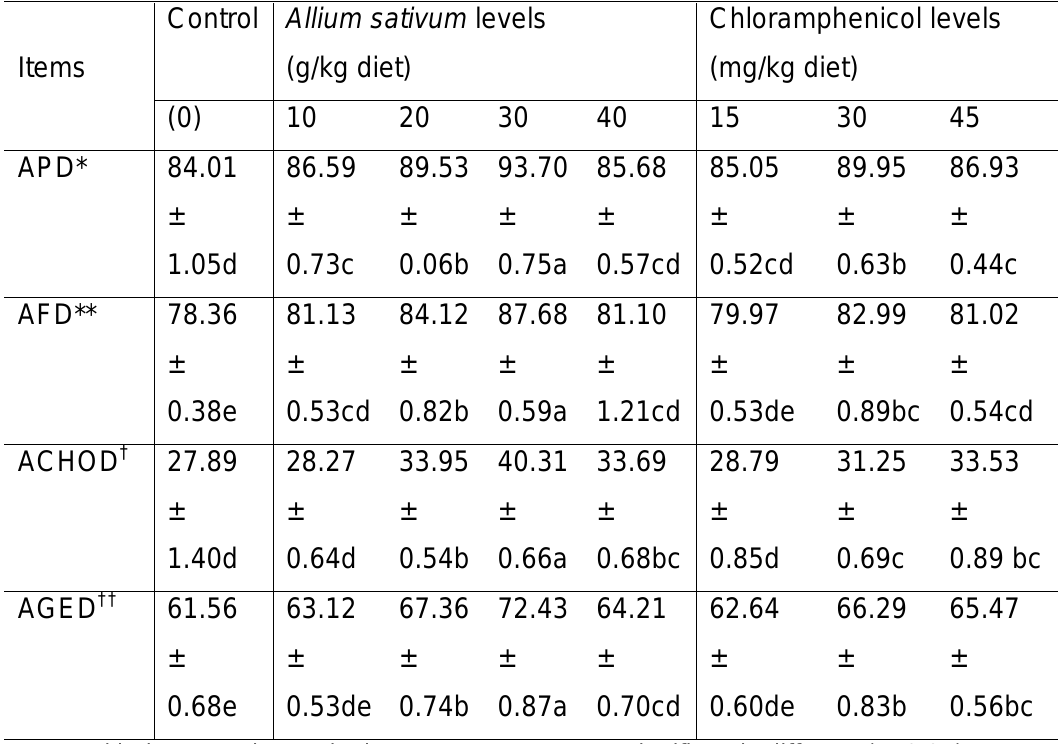
Table 3: Apparent nutrients digestibility (%) for garlic and antibiotic diets administered to Nile tilapia ( O. niloticus ) during the experimental period. Control (g/kg